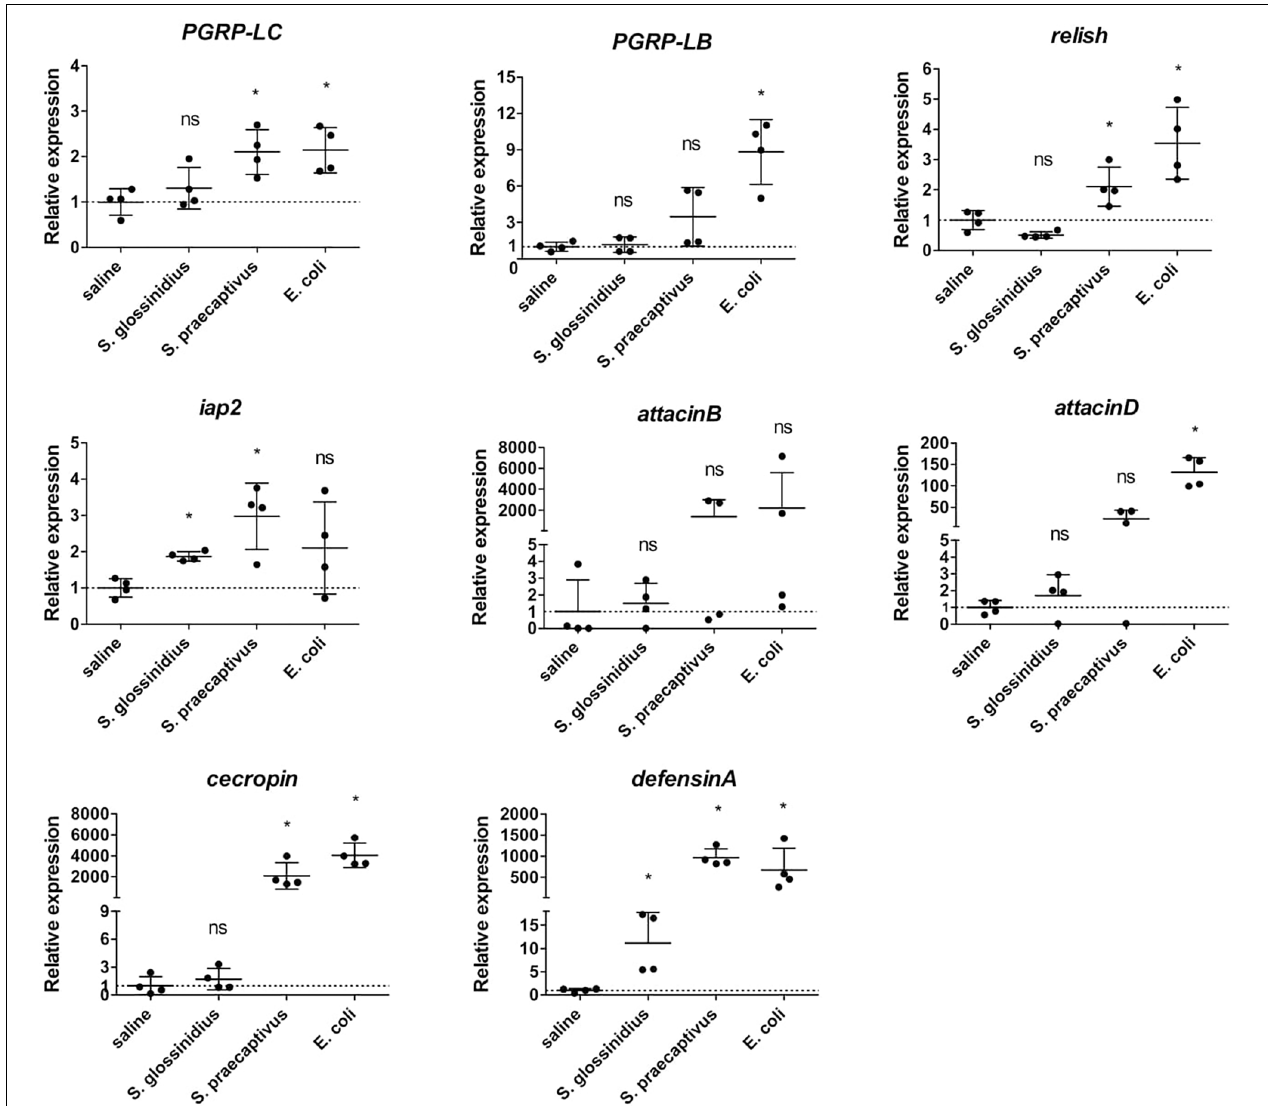
FIGURE 6 | Relative expression levels of innate immunity-related genes in the abdomen of S. glossinidius -free ( Gmm Sod − ) flies exposed to 10 6 CFU Sodalis glossinidius , 10 6 CFU Sodalis praecaptivus , or 10 5 CFU E. coli and their corresponding injection-control with sterile saline. Bacterial exposure was performed on day 8 post-eclosion via intrathoracic microinjection as well as per os and total RNA was extracted after 48 h. The expression levels were obtained by qRT-PCR analysis and normalized against the two tsetse reference genes β -tubulin (GMOY000148) and pleiotrophic regulator 1 (GMOY006161). Expression in each abdomen is plotted relative to the mean of the injection-control group. Values are represented as the mean with the standard deviation. N = 4 independent replicates per group. ∗ p -value < 0.05; iap2, inhibitor of apoptosis 2; ns, not significant; PGRP, peptidoglycan recognition